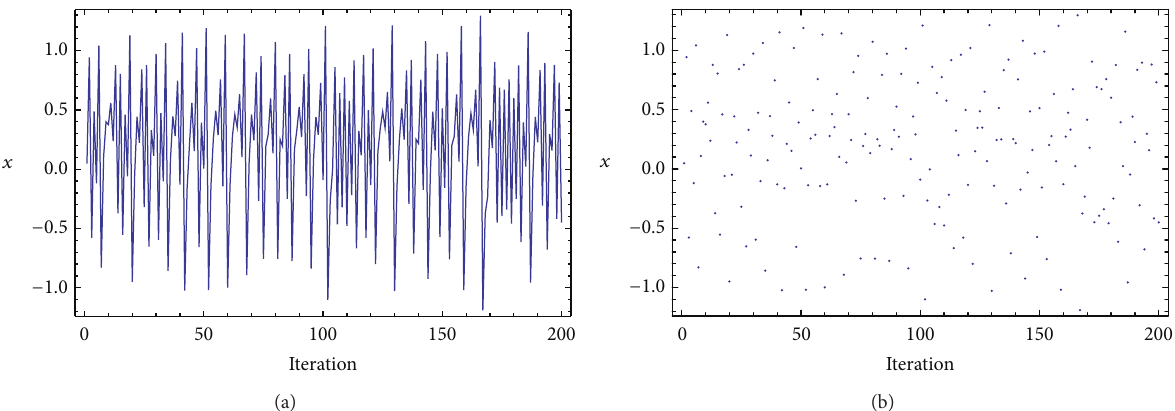
Figure 8: Iterations of the Lozi map (variable 𝑥 ) (a), iterations of the Lozi map (variable 𝑥 ), point-plot (b).